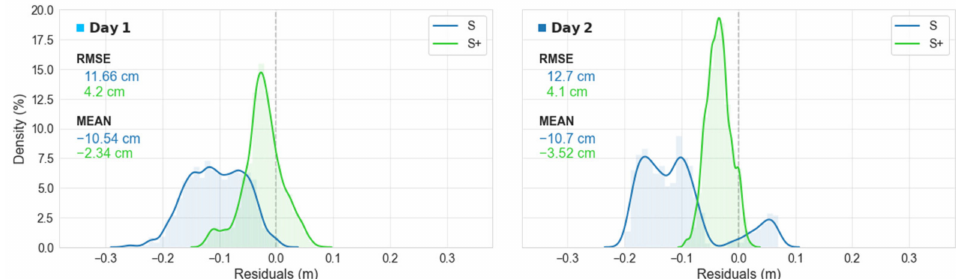
Figure 10. Density distribution of intra-day crossover residuals ( DH RES ) for the 2 model configura- tions: S (blue) and S+ (green). Residuals from day 1 and day 2 are shown, respectively, on left and right panels.